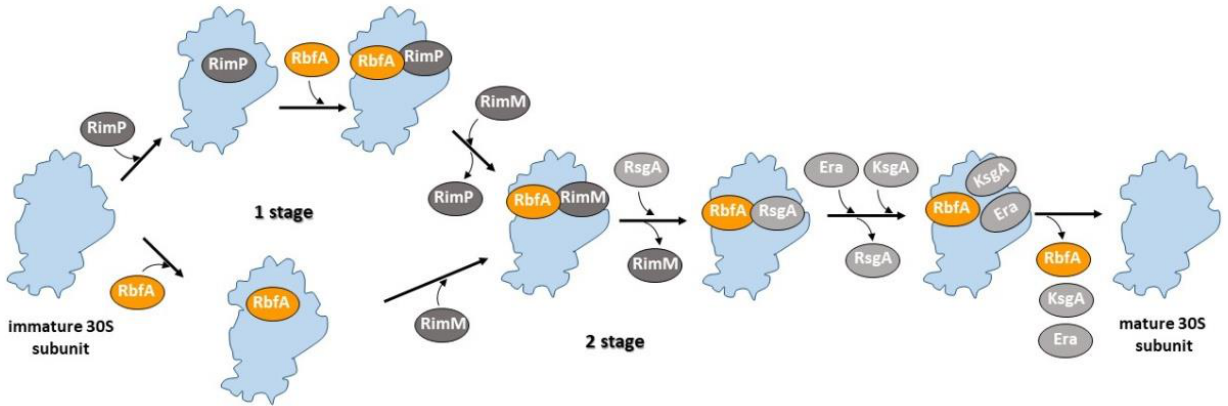
Figure 5. Mechanistic model of RbfA involvement in the 30S subunit assembly. RbfA participates in two distinct assembly stages: early formation of the central pseudoknot including folding of the head, and positioning of helix 44 in the decoding center at a later stage.